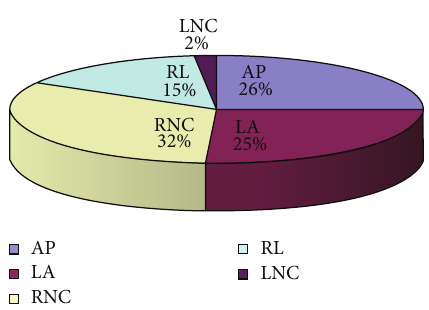
Figure 3: Presence of the BAV morphologies in sedentaries. AP: anteroposterior; LA: lateral; RL: right left; RNC: right non coronary; LNC: left